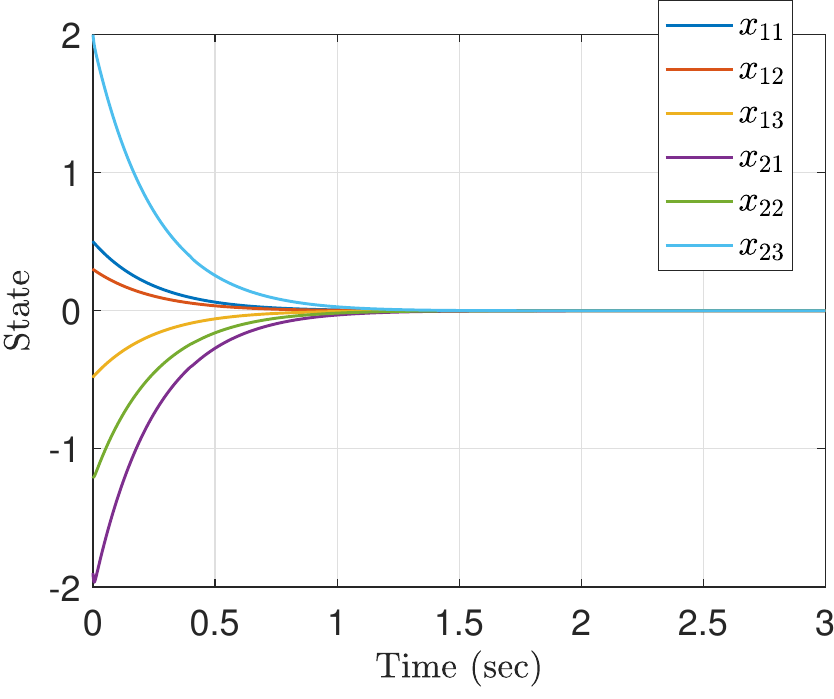
Figure 1. State trajectories of the closed-loop system.